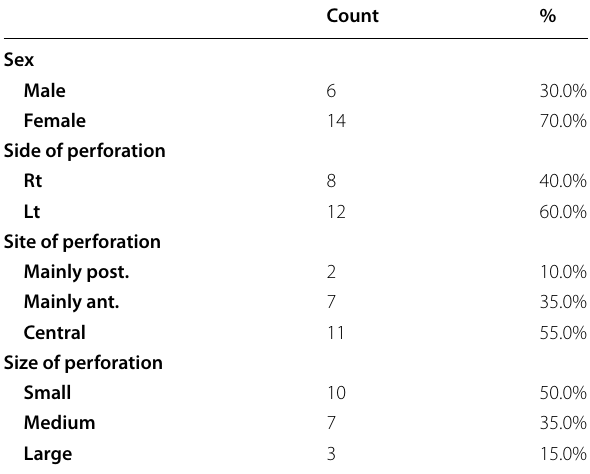
Table 1 Sex, side, site, and size of perforation distribution of the study